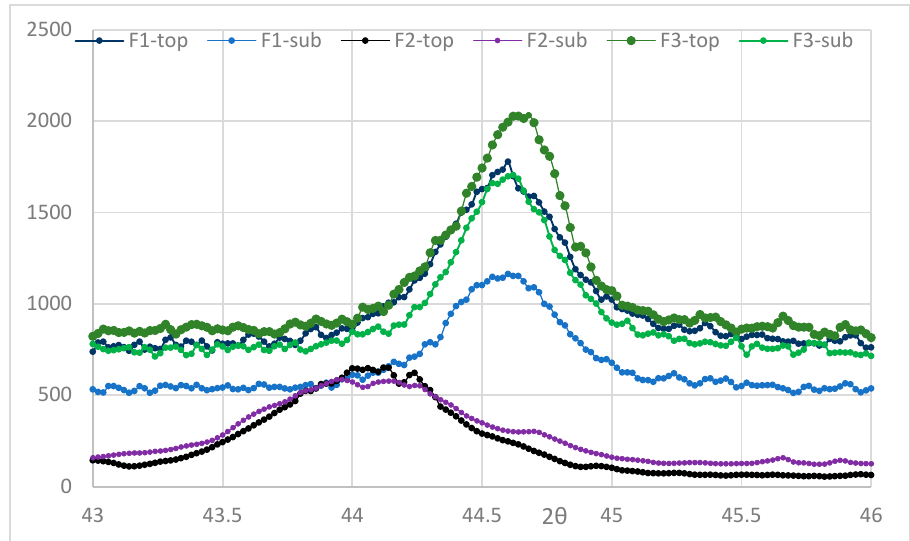
Figure 8. XRD pattern for the DED of a Ti-Fe-graded multilayer sample produced by all regimes, detailed for area of 2 θ = 45°.